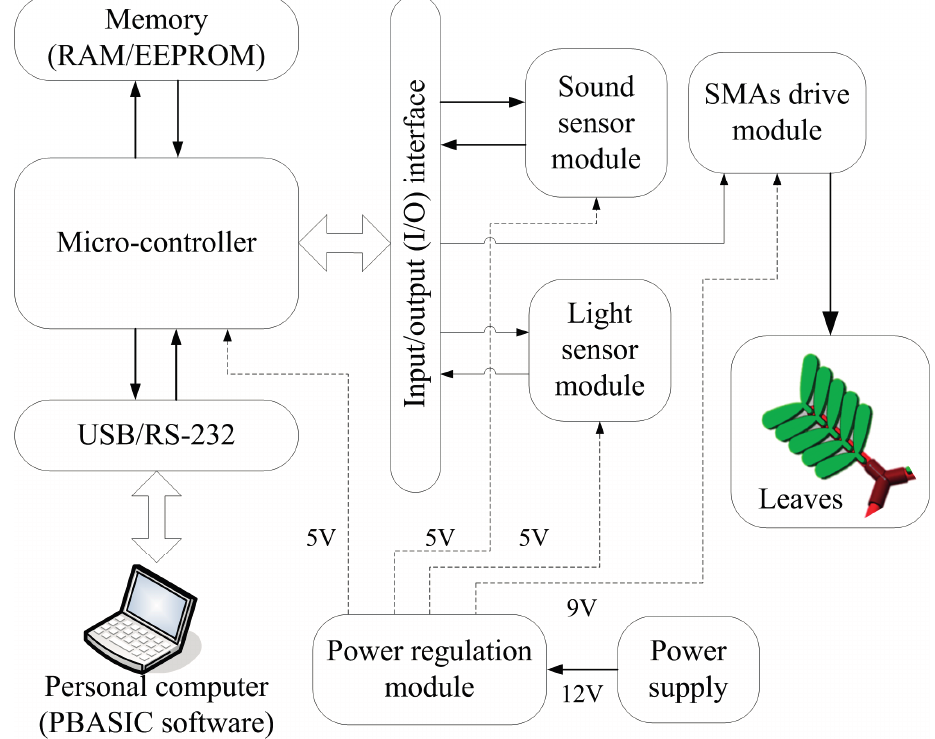
Figure 3. Bionic mimosa robot system